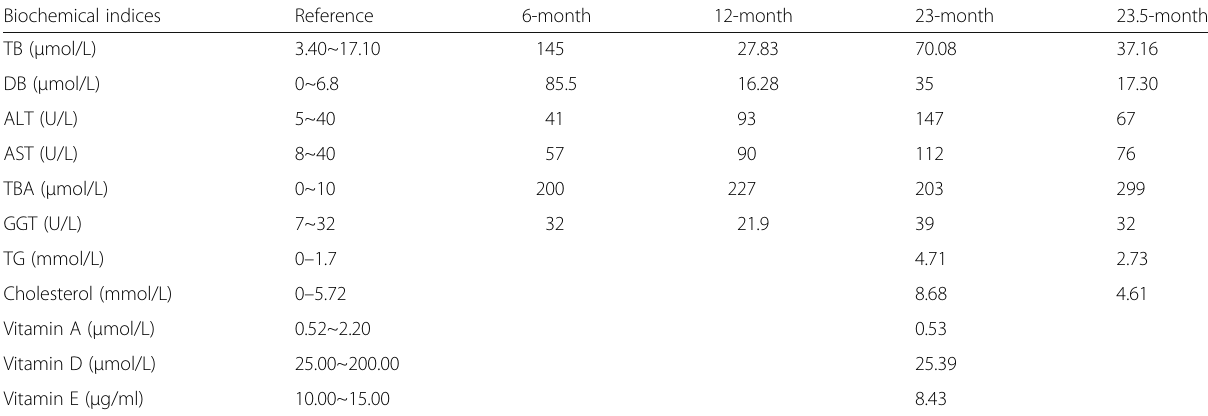
Table 1 Liver function index and routine clinical chemistry Biochemical